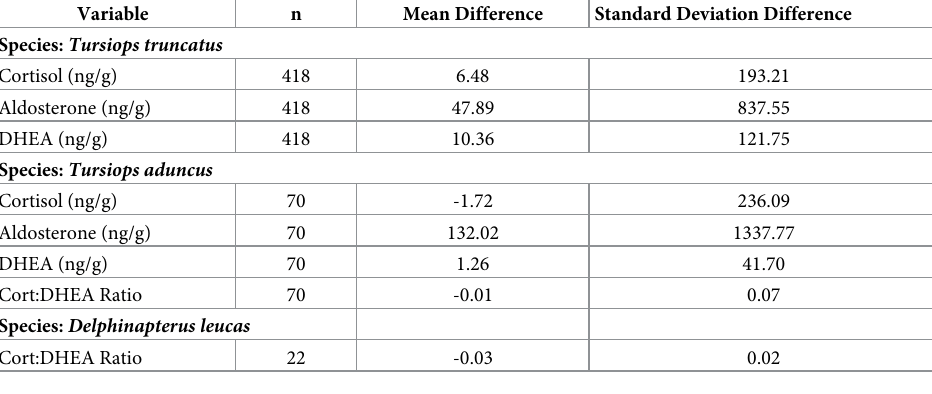
Note . n is the total number of